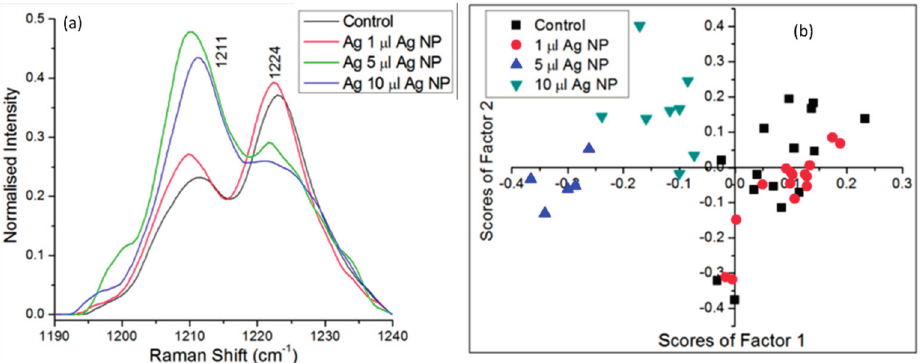
Figure 11. ( a ) LTRS analysis of red blood cells exposed to Ag nanoparticles revealed a change in the relative intensity of the 1211 and 1224 cm − 1 lines, indicating a change in the methane C-H deformation region of the cell; ( b ) A PCA provided further insight into the temporal evolution of blood cells exposed to Ag nanoparticles [69] (Reprinted under the Creative Commons Attribution